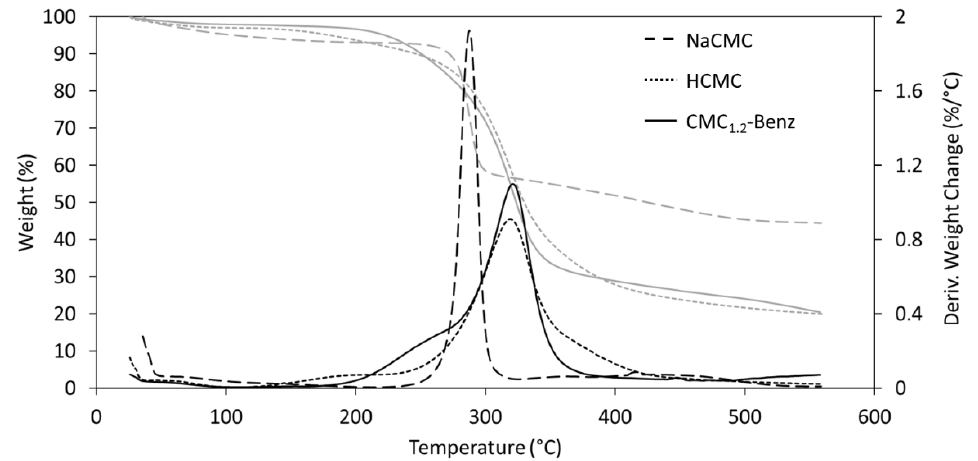
Figure 7. Thermogravimetric analysis (TGA) curves of NaCMC and CMC 1.2 -Benz (Table 1, Entry 3): Weight (%), grey lines, and Derivative Weight Change (%/°C), black lines.